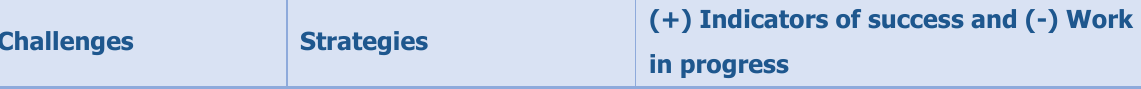
Table 10. Review, Revise, Success—Teens as Teacher Essential